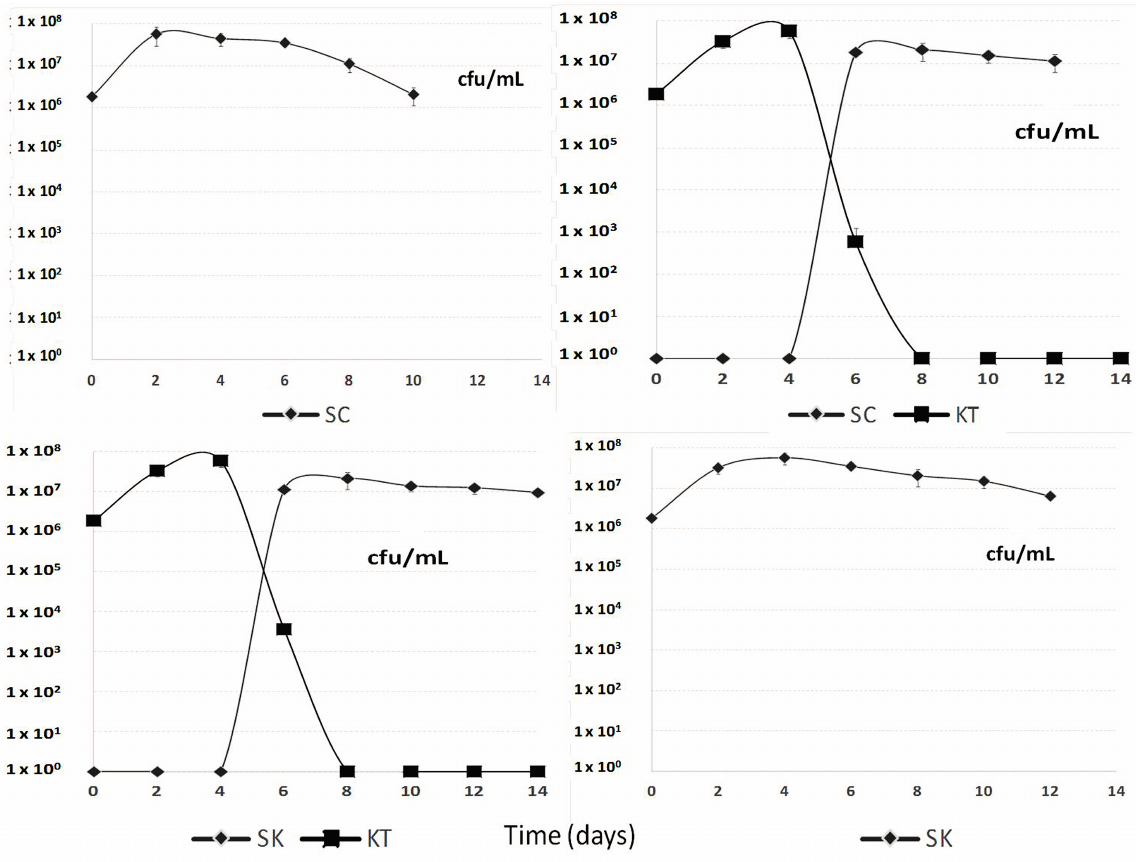
Figure 1. Population development of Saccharomyces cerevisiae 87 (SC), Kluyveromyces thermotolerans CONCERTO™ (KT) and Schizosaccharomyces pombe V2 (SK) during the different sequential fermentation